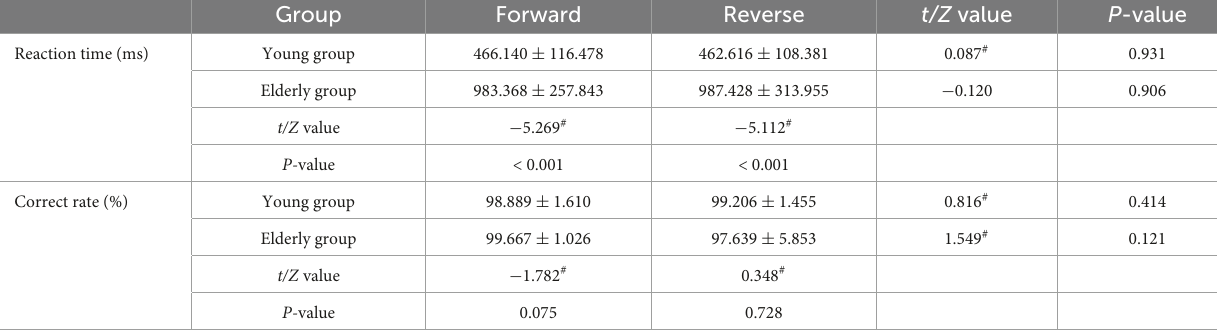
TABLE 2 Comparison of reaction time and correct rate of judgment test between young and